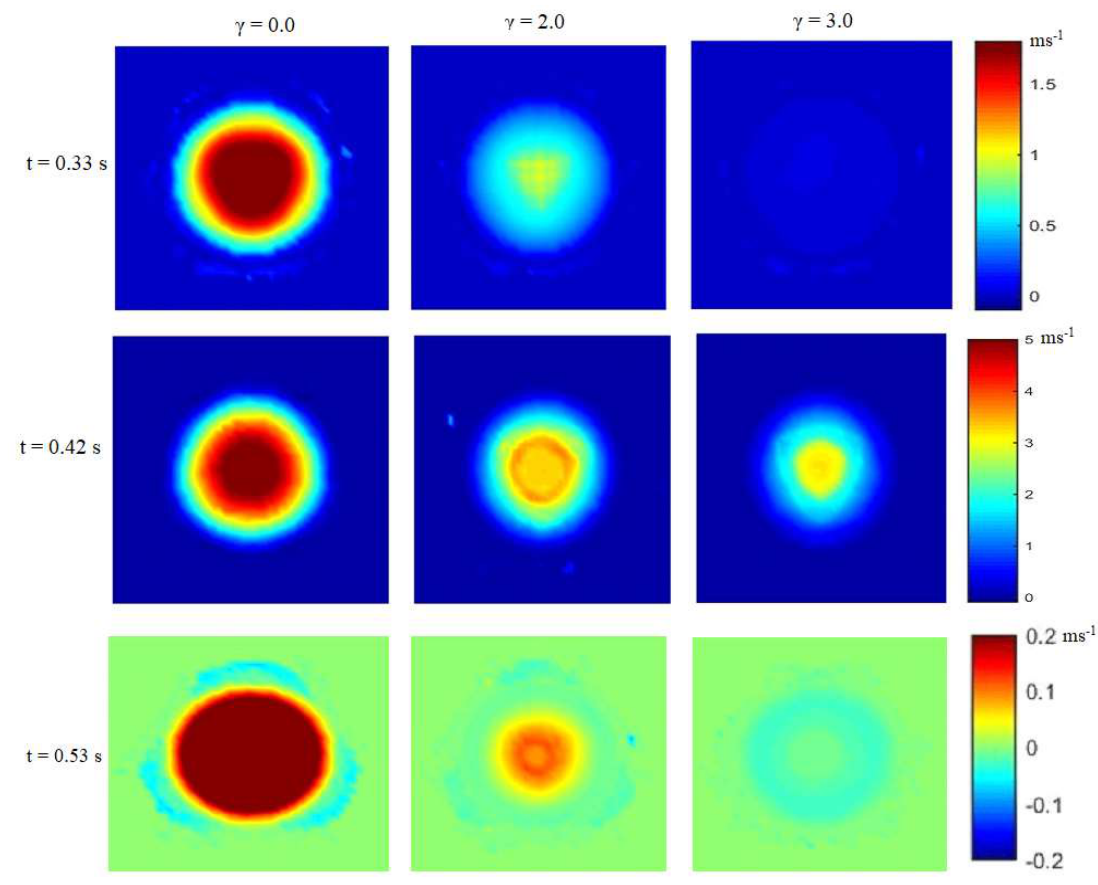
Figure 4. Velocity profile at different time steps.